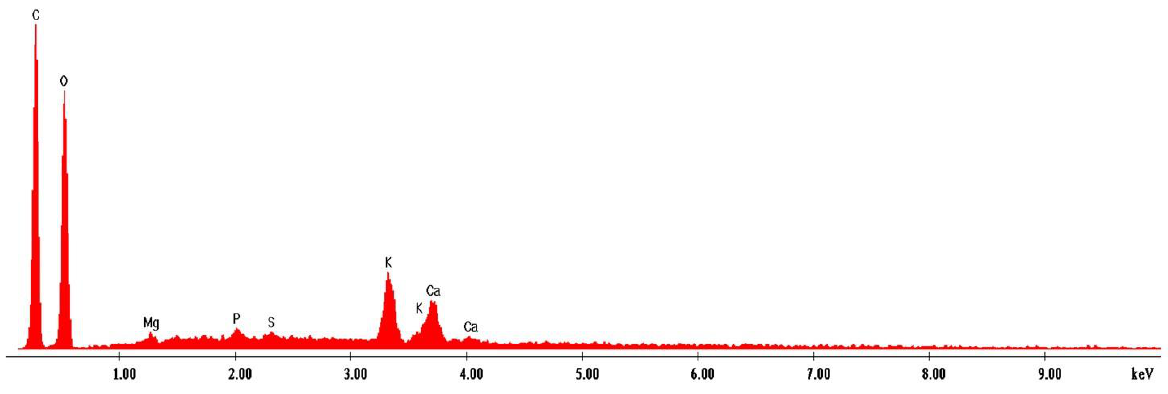
Figure 13. EDX spectrum of curcuma sample.